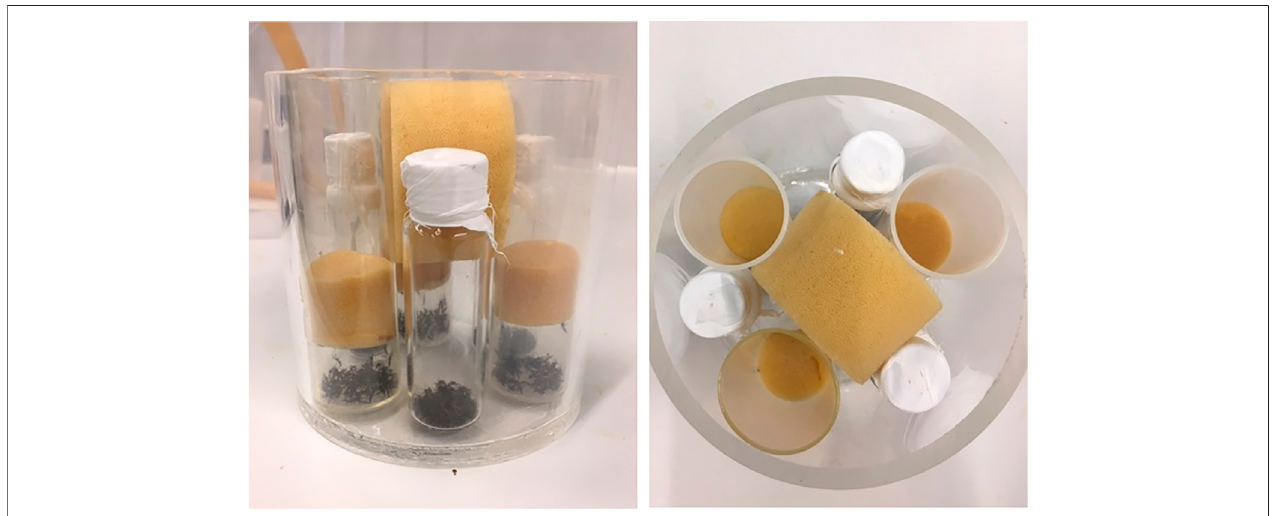
FIGURE 1 | Irradiation set-up for adults irradiated in nitrogen or in air. One biological repetition with each three technical repetitions were irradiated simultaneously foreachtreatment,withina5